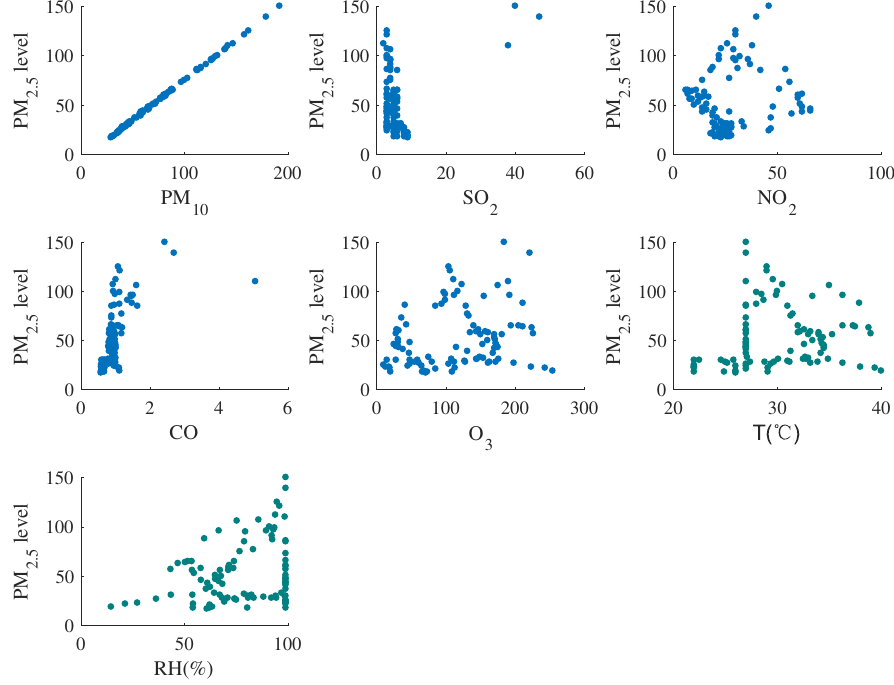
Figure 2. The scatterplot of PM 2.5 concentration with other monitored